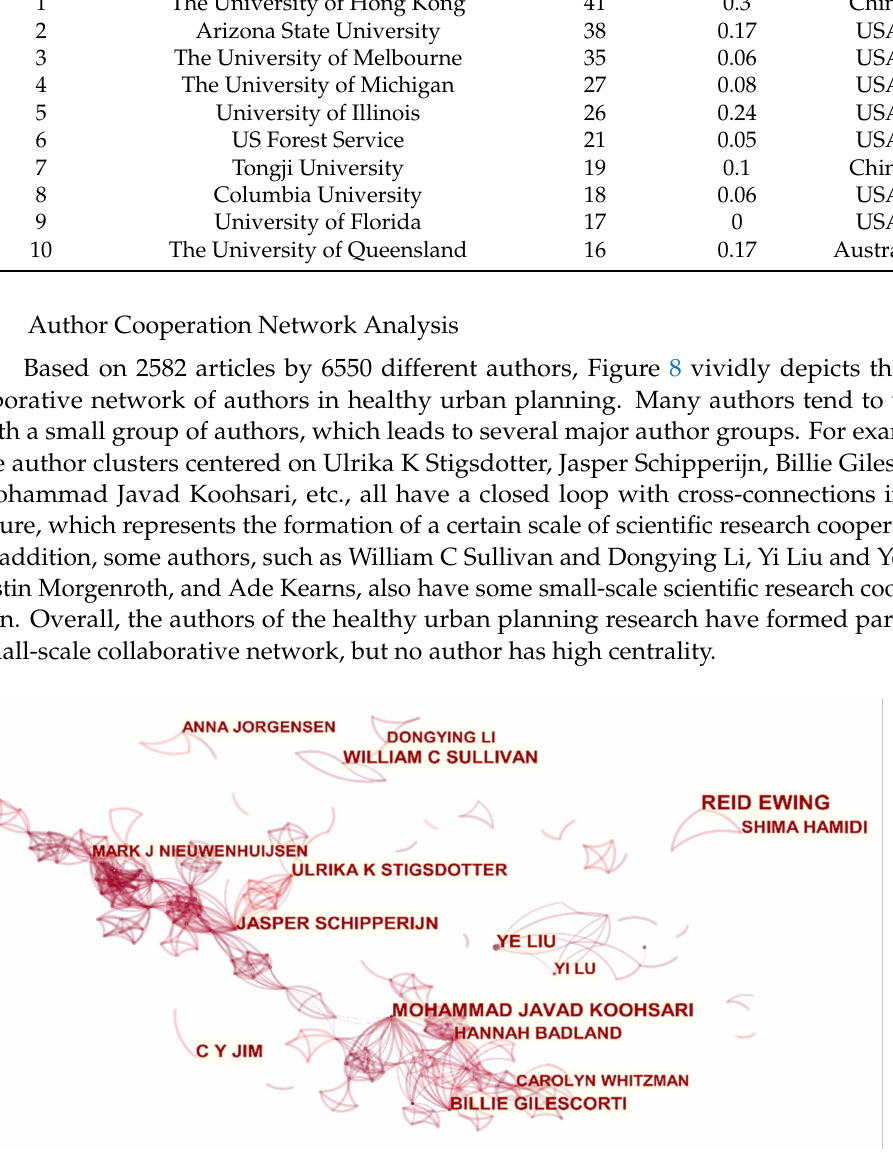
Figure 8. Visualization map of authors participating in healthy urban planning